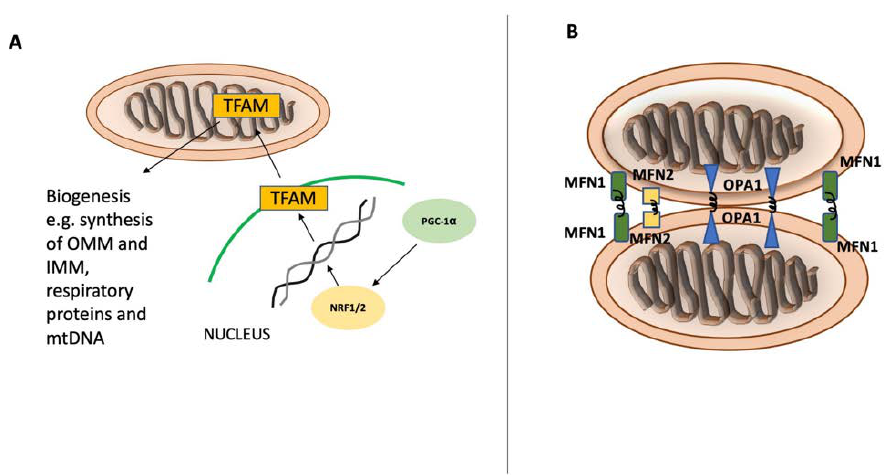
Figure 1. Mitochondrial biogenesis and fusion. Peroxisome proliferator-activated receptor gamma coactivator 1-alpha (PGC-1 α ) is the main regulator of mito- chondrial biogenesis ( A ) and translocates into the nucleus after its activation. In the nucleus, PGC-1 α stimulates NRF1 and NRF2 expression, leading to increased activity of mitochondrial transcription factor A (TFAM), which orchestrates the synthesis of mtDNA and proteins. Mitochondrial fusion ( B ) is controlled by mitofusin-1 (MFN1) and mitofusin-2 (MFN2) on the mitochondrial outer membrane and by optic atrophy 1 (OPA1) on the inner mitochondrial